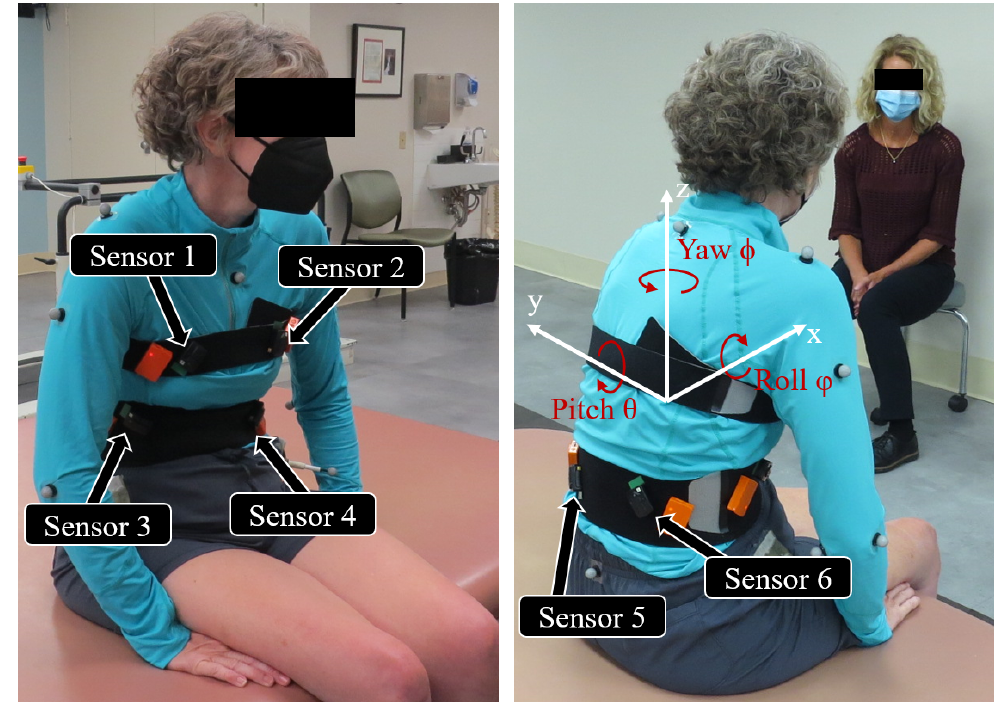
Figure 2. Locations of the 3-axis accelerometers and reflective markers on the subject. The body’s anatomical coordinate frame is shown in the right image. Pitch, roll, and yaw refer to trunk flexion and extension, lateral bending, and axial rotation about the x, y, and z anatomical axes,